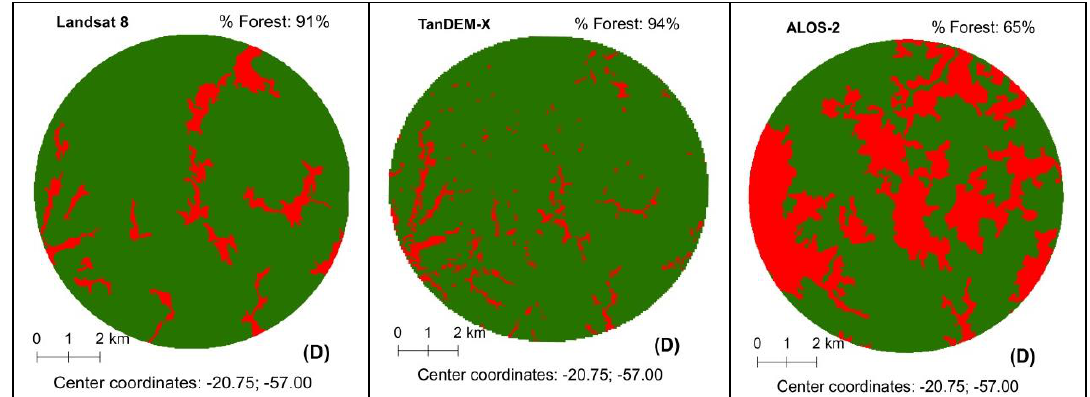
Figure 14. Examples of forest estimations obtained by the TanDEM-X and ALOS-2 data sets over the Cerrado biome showing cases of TanDEM-X forest underestimation in the municipalities of Mineiros ( A ), Goiás State and Natividade ( B ), Tocantins State as well as cases of ALOS-2 forest underestimation in the municipalities of Inhumas ( C ), Goiás State and Porto Murtinho ( D ), Mato Grosso do Sul State. The corresponding forest estimations from Landsat 8 are shown in the first column. Green = forest; red = non-forest; blue = water body.